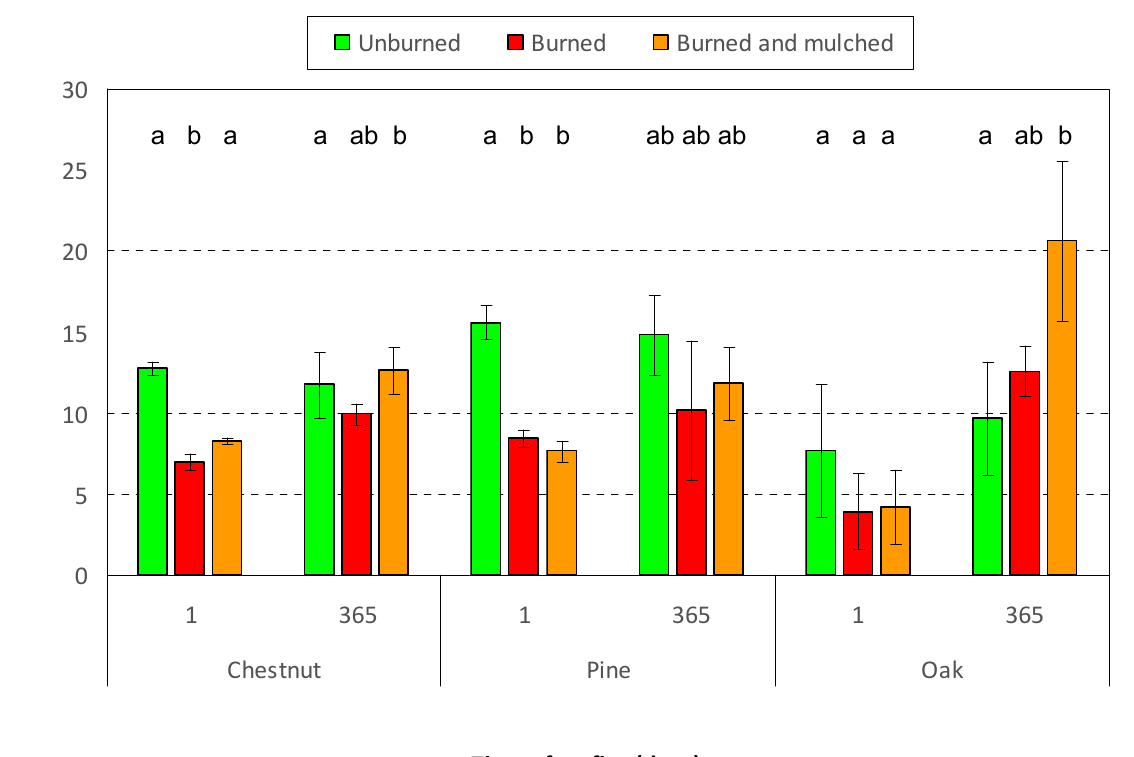
Figure 3. Water infiltration rate measured using a portable rainfall simulator after prescribed fire and soil mulching with fern in the experimental site (Samo, Calabria, Southern Italy). Note: different lowercase letters indicate significant differences in the interaction between soil conditions and time after fire, respectively, after Tukey’s test ( p < 0.05).